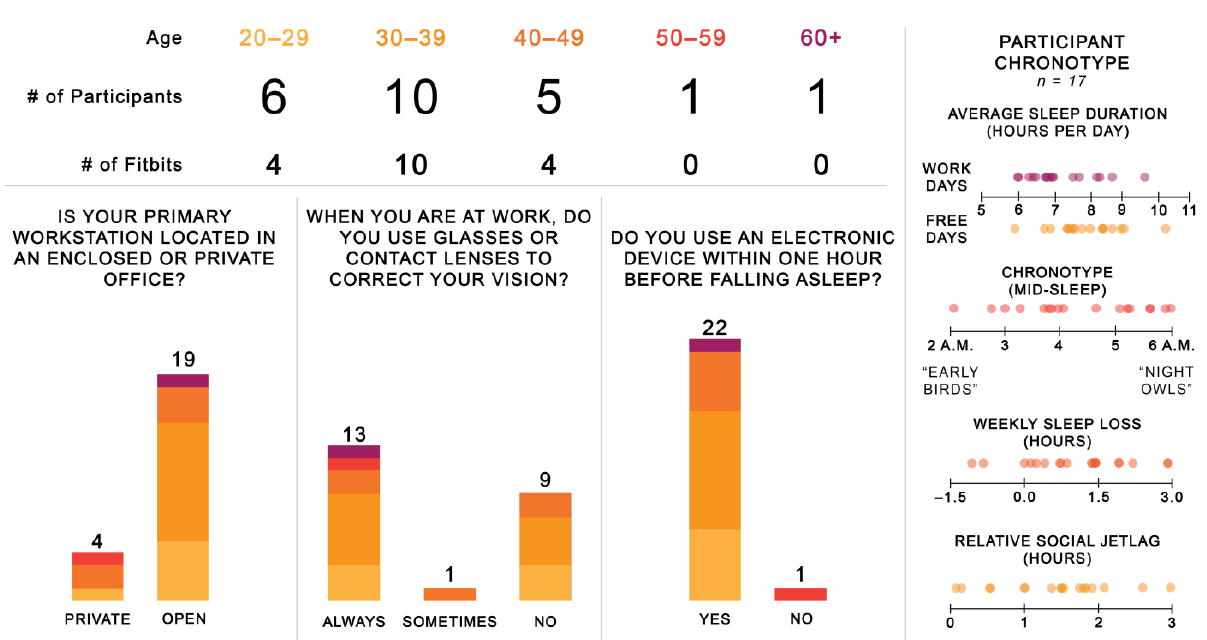
Figure 4. Participant demographic and chronotype summary. Sufficient chronotype data were only collected for 17 of the 23 participants. Weekly sleep loss is the difference between sleep duration on workdays and free days. Some participants reported sleeping less on free days than on workdays. Relative social jetlag represents the difference between mid-sleep on workdays and free days. Greater social jetlag means the participant reported different sleep and wake times on free days compared to workdays.